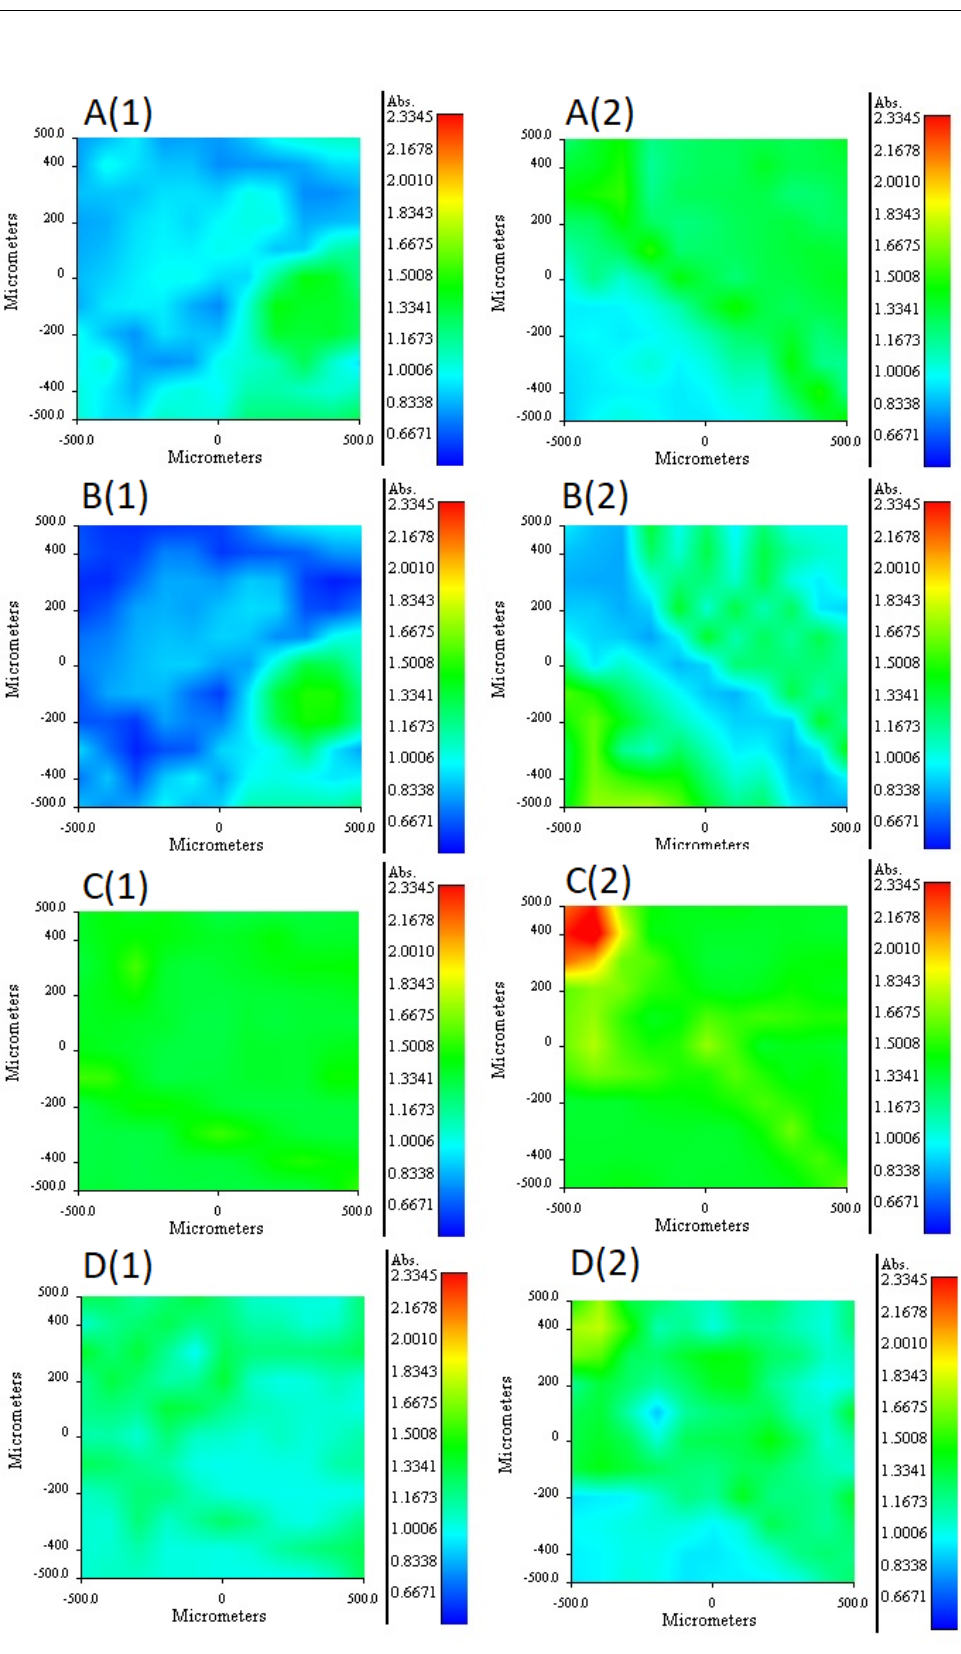
Figure 6. RIMM maps monitoring the distribution of 2NPOE in PIM m2 ( A ), Ionquest ® 801 in PIM m2 ( B ), 2NPOE in PIM m4 ( C ), and Ionquest ® 801 in PIM m4 ( D ). (1) stands for face 1 and (2) for face 2 of the PIMs (see text).